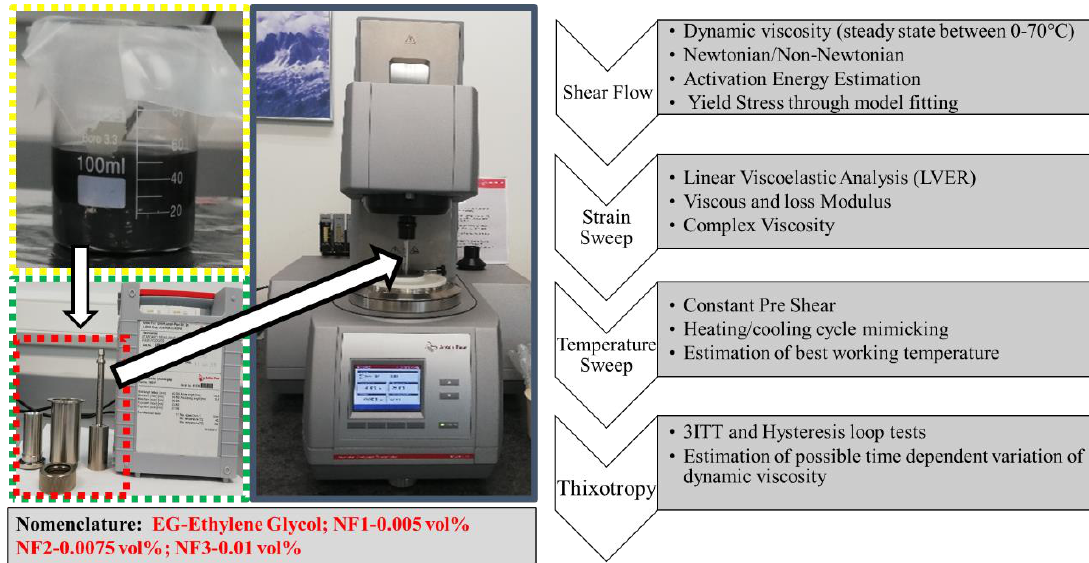
Figure 2. Rheological measurements scheme and nomenclature.